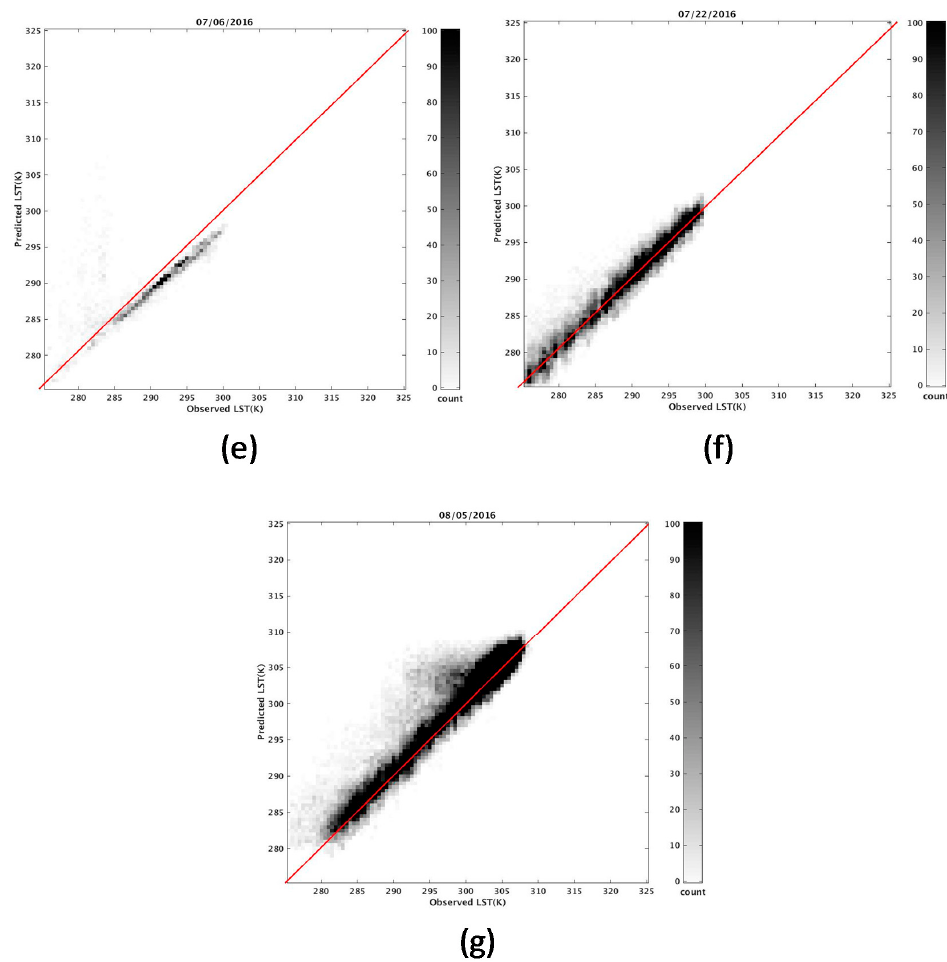
Figure 5. ( a – g ) represent the scatter plot between the retrieved LST and LST products at the seven Landsat passing days correspondingly. Table 4. Statistics obtained from the comparison of retrieved LST against observed Landsat 8 LST.